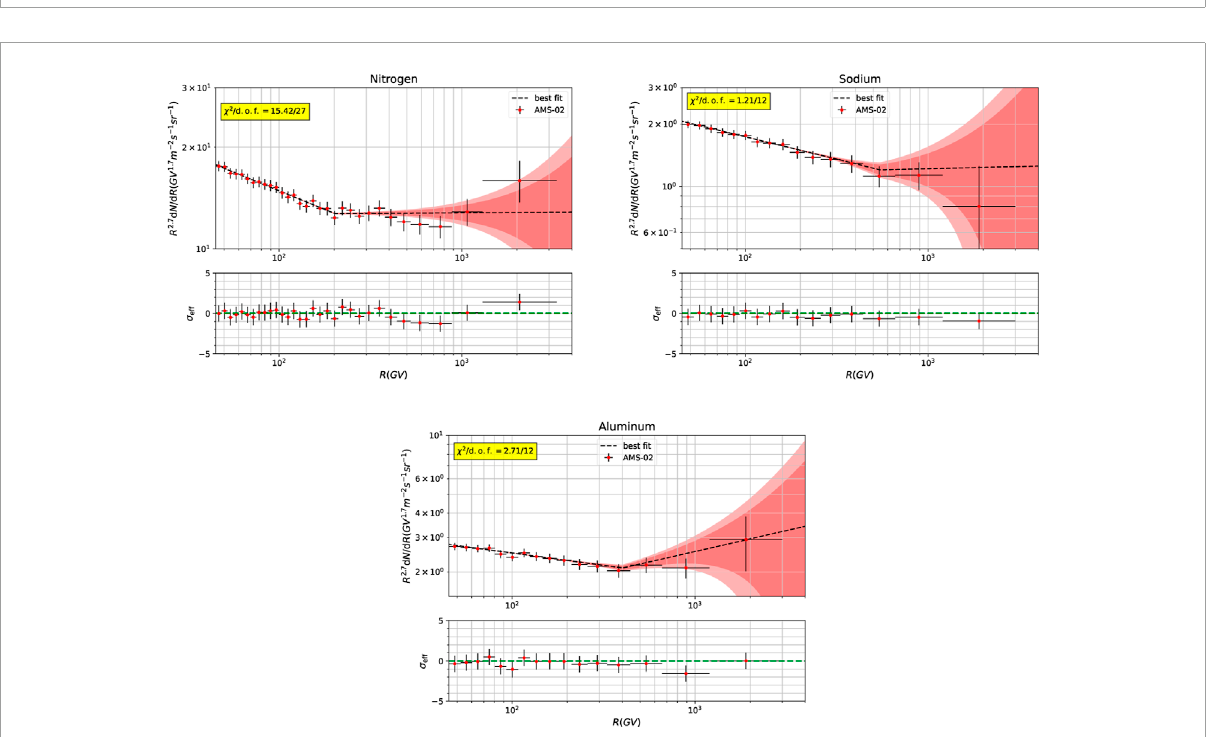
FIGURE 3 Fitting results and corresponding residuals to the hybrid CR nuclei spectra (N, Na, and Al). The 2 σ (deep red) and 3 σ (light red) bounds are also shown in the subfigures. The relevant reduced χ 2 value of each spectrum is given in the subfigures as well.